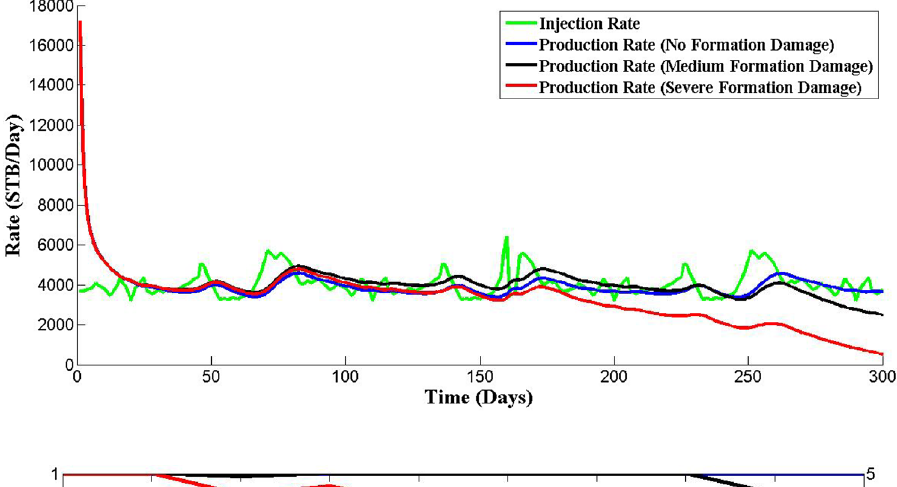
Fig. 8 Connectivity factor and